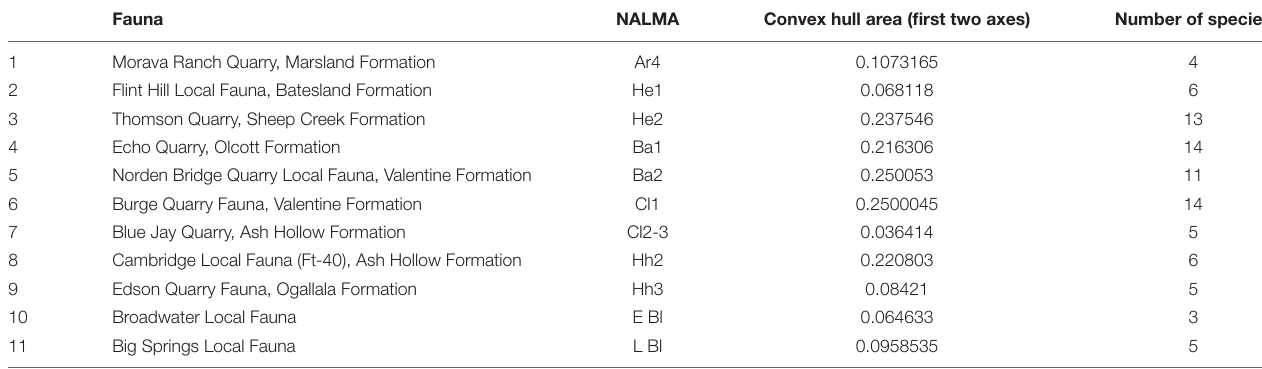
TABLE 5 | Disparity and diversity of the faunas of the Neogene of North America. Fauna NALMA Convex hull area (first two axes)